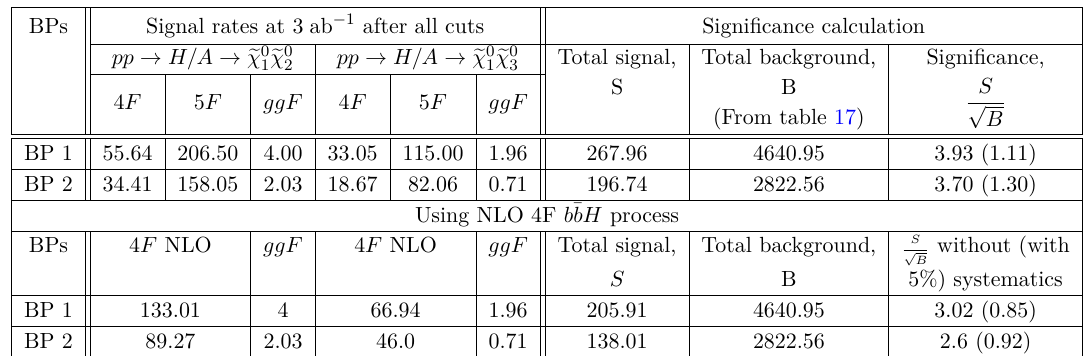
Table 18. The signal yield along with signal significance for the b-tag b ¯ b + /E are Zh , W h and Zγγ . We generate the Zh and W h background upon merging with one additional jet in the final state where the SM Higgs decays to γγ . For the Zγγ , we decay the Z boson into neutrinos and merge with one extra jet in the final state. Also, we gen- erate t ¯ th with h → γγ which is a subdominant background to this final state. For details see appendix